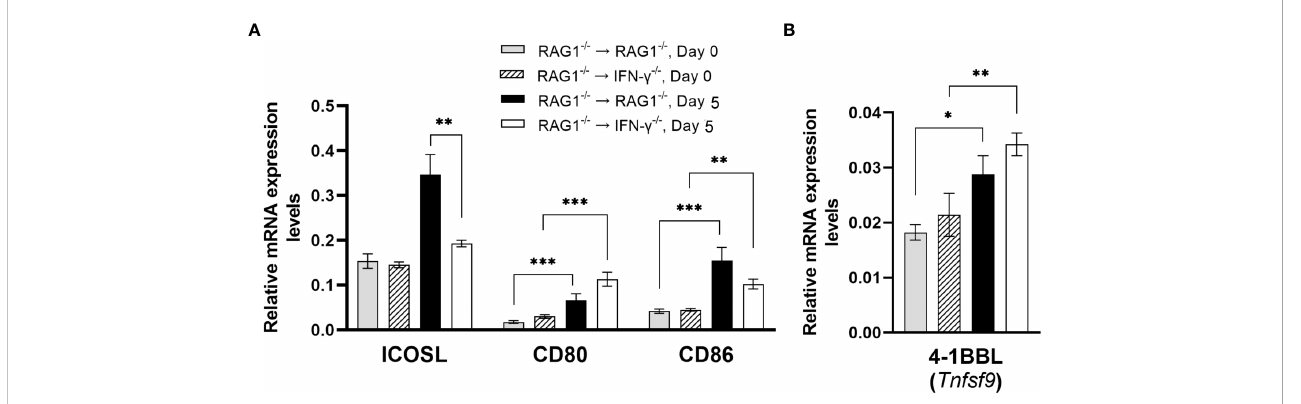
FIGURE 8 Cerebral mRNA levels for co-stimulatory molecules are upregulated by IFN- g production by brain-resident cells during reactivation of cerebral T. gondii infection. For the details of experimental methods, see the legend of Figure 1. The mRNA levels for (A) ICOS, CD80, CD86 and (B) 4-1BBL were measured at both Day 0 and Day 5 in the brains of both groups of mice were measured using NanoString nCounter Mouse Myeloid Innate Immunity Panel. * P <0.05, ** P <0.01, and *** P <0.001. The data were combined from two independent experiments (n=5 for Day 0 and n=7 for Day 5 in both RAG1 -/- → RAG1 -/- and RAG1 -/- → IFN- g -/- mice).